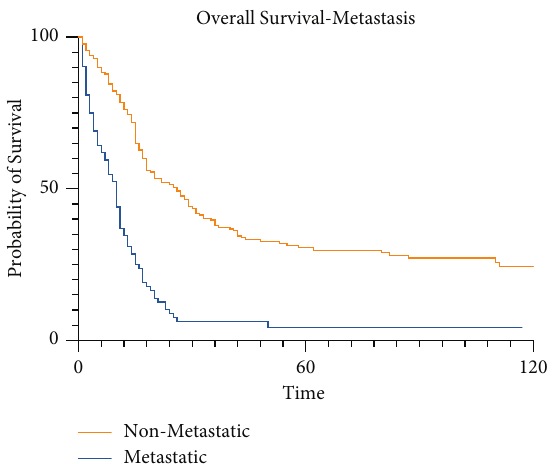
patients by presence of metastatic